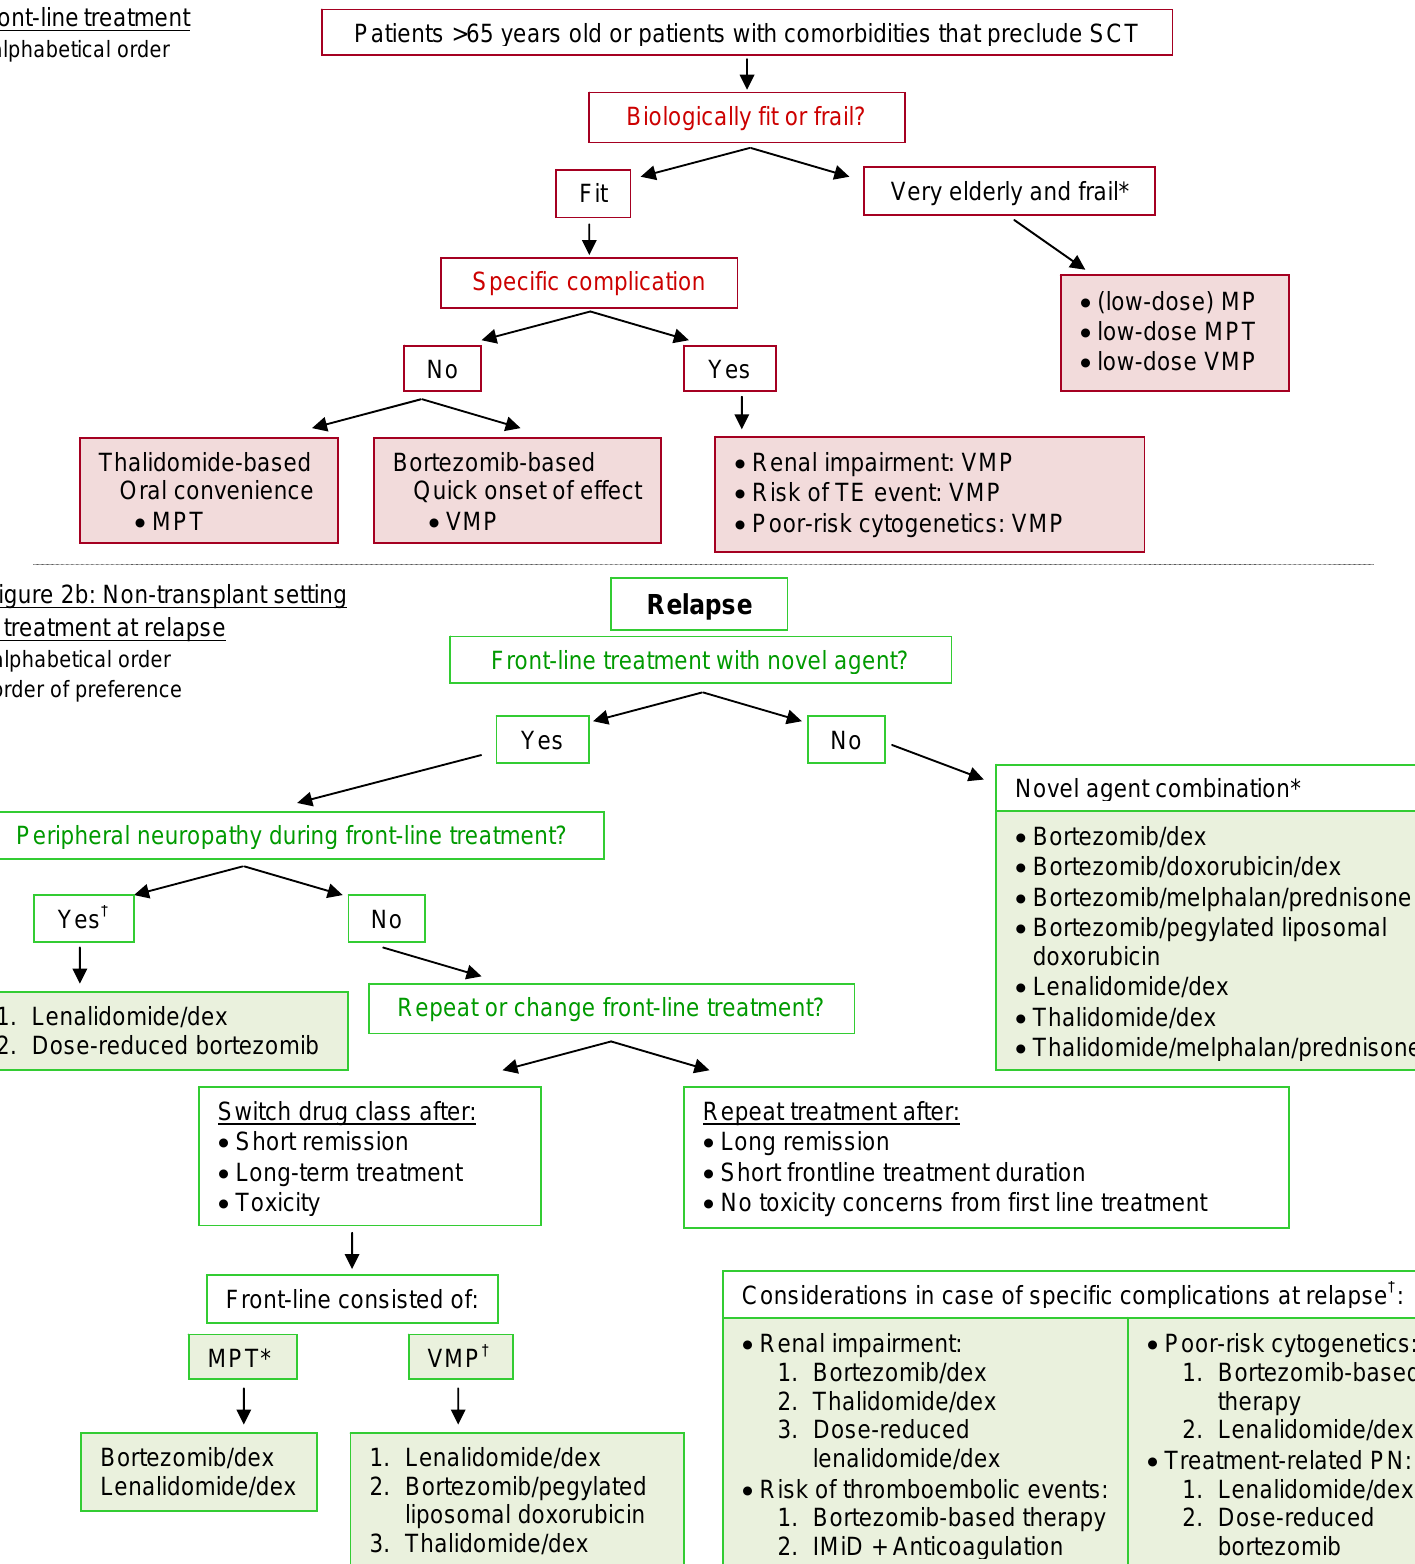
Figure 2: MM Treatment Tree – Non-transplant setting Figure 2a: Non-transplant setting – front-line treatment *alphabetical order